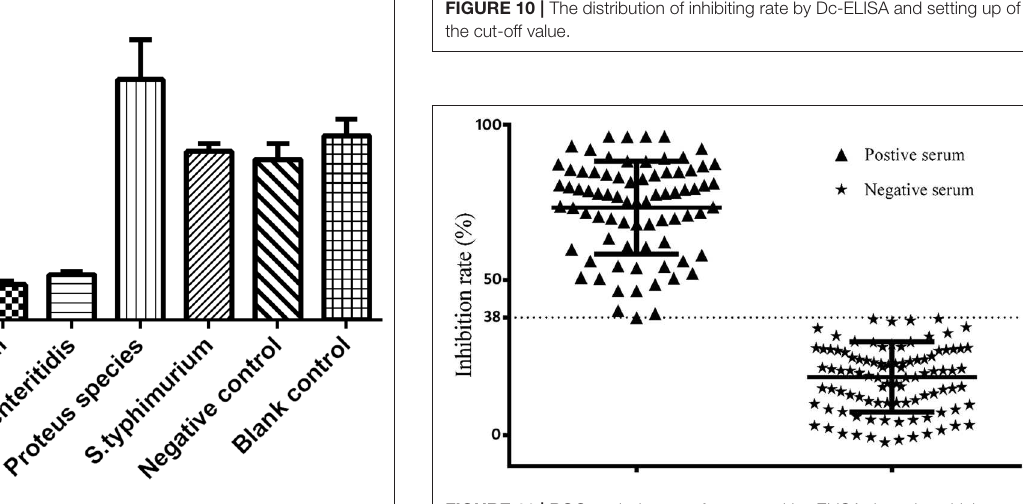
FIGURE 9 | The OD value of chicken sera against different pathogens for specificity analysis.